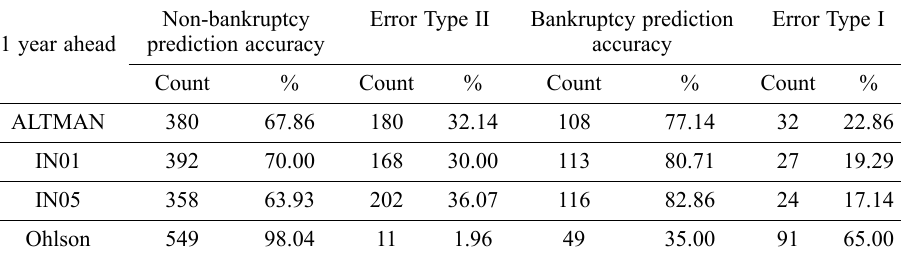
Table 3. Model I validation – one year ahead forecast